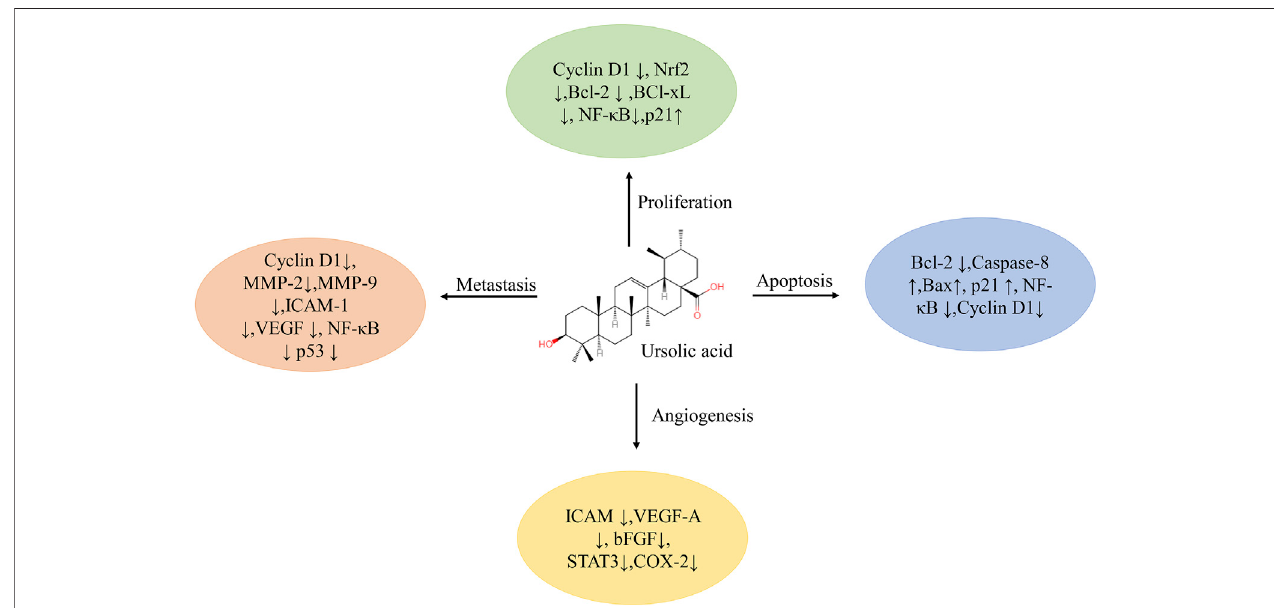
FIGURE 1 | Multiple molecular targets modulated by ursolic acid. Abbreviations: Bcl-2, B-cell lymphoma-2; Bcl-xL, B-cell Lymphoma/Leukemia-xL; bFGF, basic fi broblastgrowth factor; COX,cyclooxygenase;ICAM,intercellular adhesion molecule; MMP,matrixmetalloprotease; NF- κ B,nuclearfactorkappa-B;Nrf,nuclearfactor E2-related factor; STAT, signal transducers and activators of transcription; VEGF, vascular endothelial growth factor.